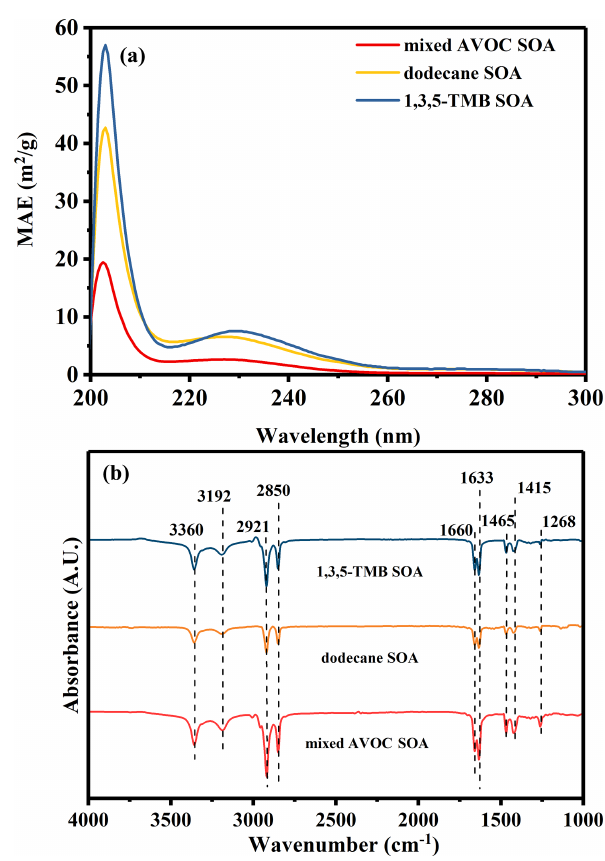
Figure 6. (a) UV–Vis spectra (MAE) of the n -dodecane, 1,3,5- TMB, and mixed AVOC SOA. As the absorbance at wavelengths > 300nm is negligible, we only show the range from 200 to 300nm. (b) ATR-IR spectra for the n -dodecane, 1,3,5-TMB, and mixed AVOC SOA using a background spectrum obtained without a sam- ple as the